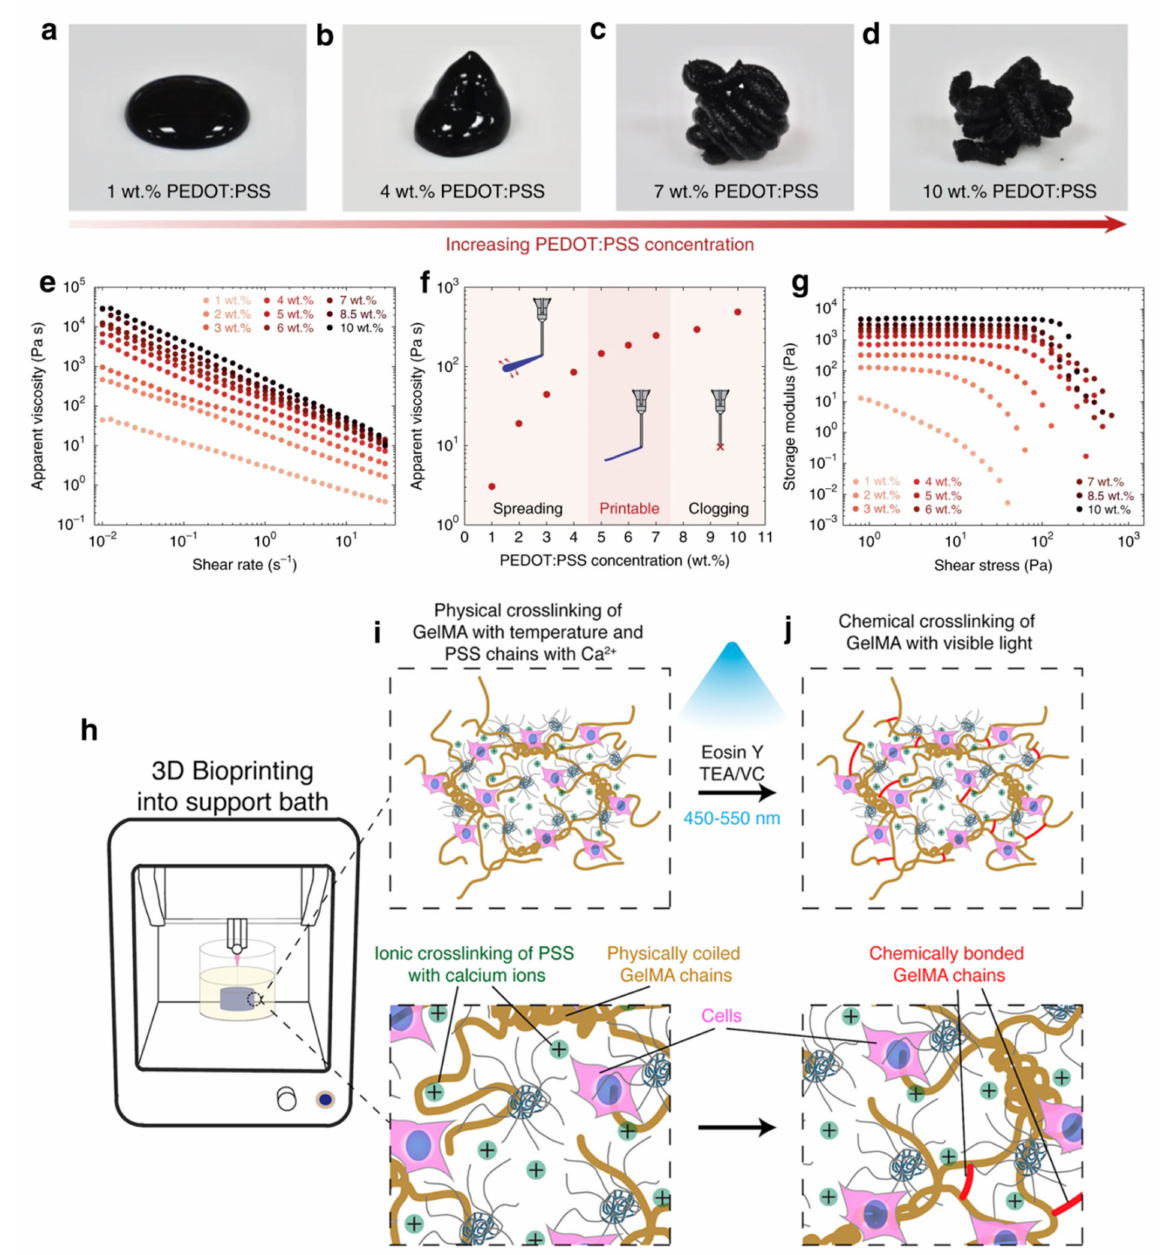
Figure 5. ( a – d ) Images of redispersed suspensions of PEDOT:PSS nanofibrils at various concentrations. ( e ) Apparent viscosity of PEDOT:PSS nanofibril suspensions as a function of ( e ) shear rate and ( f ) concentration. ( g ) Shear storage modulus of PEDOT:PSS nanofibril suspensions as a function of shear stress. Adapted with permission from Ref. [20], Copyright 2020, Springer Nature. ( h ) Schematic of 3D bioprinting of cell-laden GelMA/PEDOT:PSS bioink into a coagulation bath containing aqueous calcium chloride at 4 ◦ C. ( i ) Physical and ionic crosslinking in 3D bioprinted GelMA/PEDOT:PSS structures. ( j ) Photo-cross-linking of GelMA chains in 3D bioprinted GelMA/PEDOT:PSS structures. Adapted with permission from Ref. [22]. Copyright 2019, American Chemical